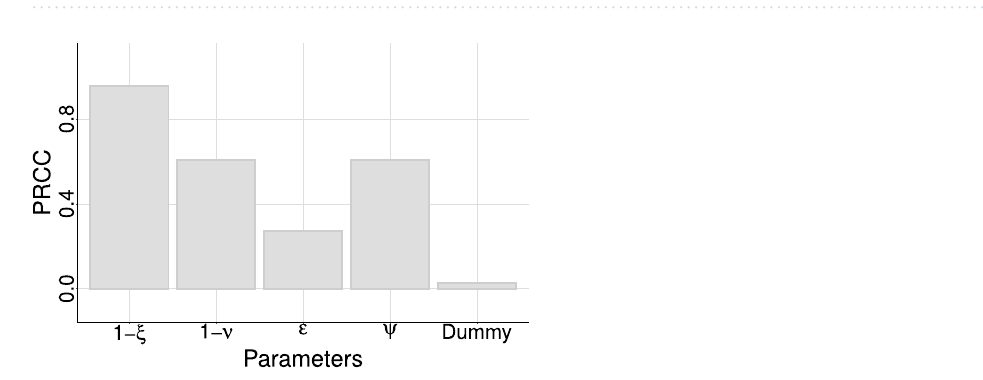
Figure 4. Reduction on the number of cases versus time of starting control. In ( a ), ψ = 0.1 and in ( b ), ψ = 0.3 ; where ψ is the fraction of the population tested. Among the 29 municipalities involved in the study we highlight four of them: Itumbiara, Água Branca, Sobral, and Dourados; the other ones are shown in grey lines.